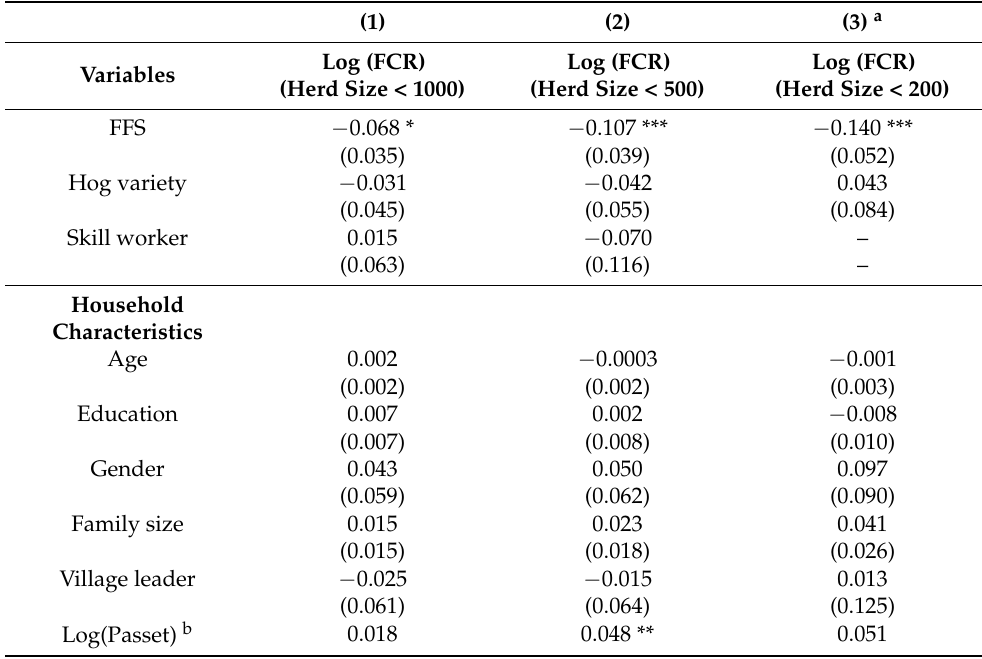
Table 4. Estimated impact of FFS on feed conversion ratio.